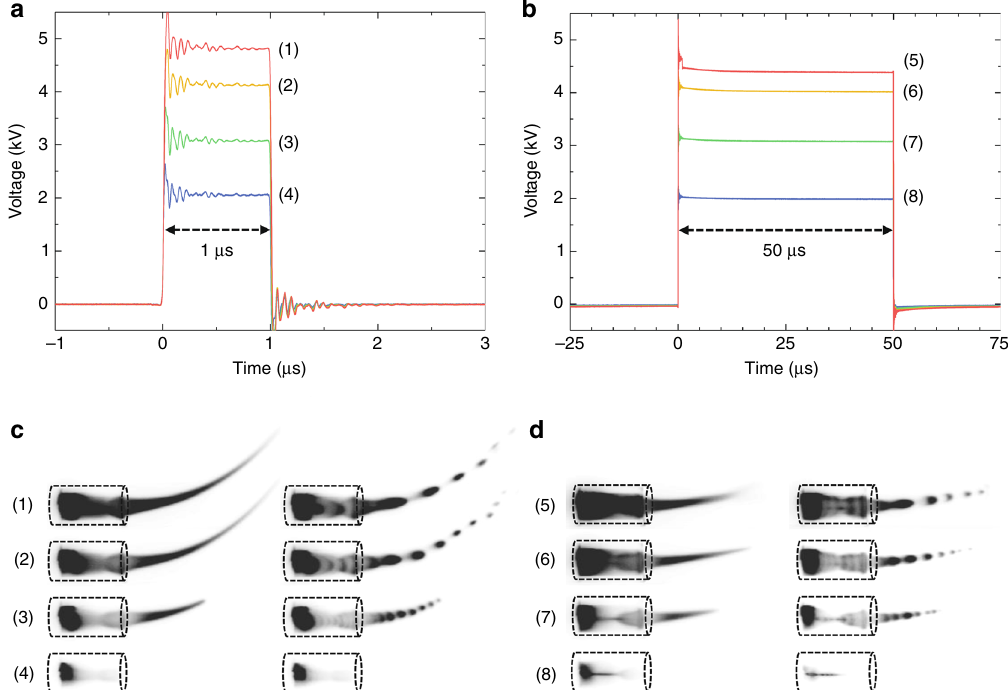
Fig. 2 Voltage waveforms with different pulse widths and heights. Voltage pulses having pulse widths of a 1 μ s and b 50 μ s at different pulse heights applied to the electrode. Time-integrated (left column) and composite nanosecond-resolved (right column) plasma emission images at c 1 μ s and d 50 μ s; speci fi c voltage heights are denoted by numbers in this fi gure. The glass tubes with an inner diameter of 3.5 mm are used as substitute for scale bars for all